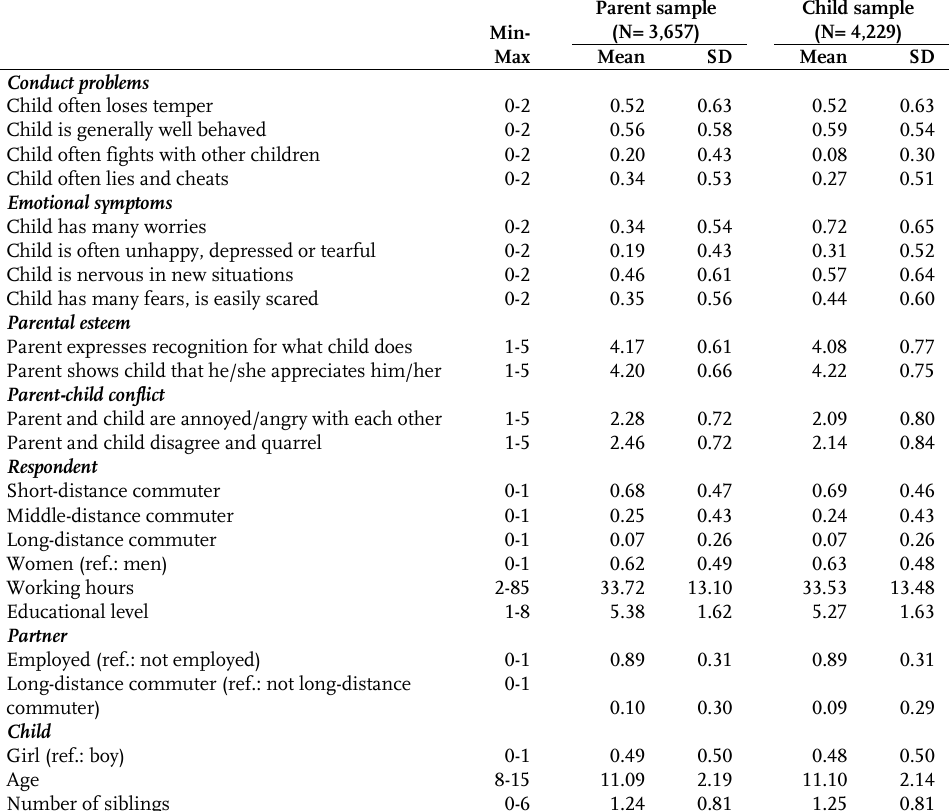
Table 2 : Descriptive statistics of study population, parent and child